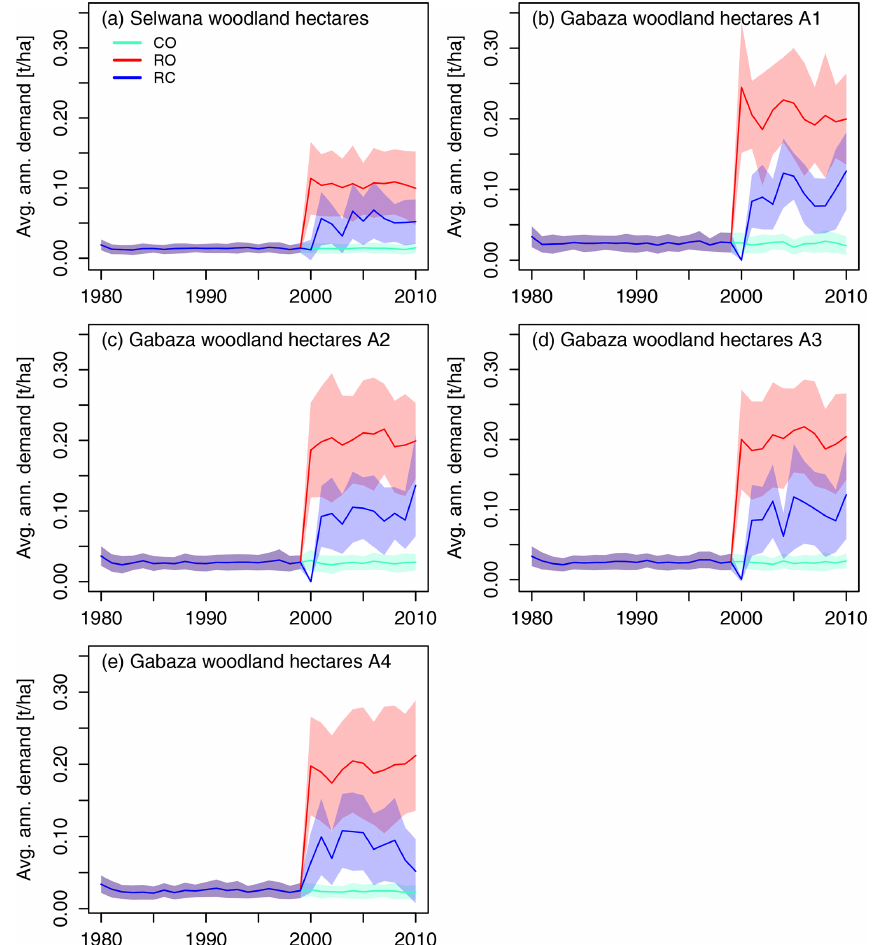
Figure 8. The mean per-hectare annual biomass demand across simulated woodland hectares at Selwana (a) and the four sub-areas at Gabaza (b–e) . Non-zero biomass demand in the CO scenario is due to the prescribed low-intensity background grazing caused by small game when cattle are completely